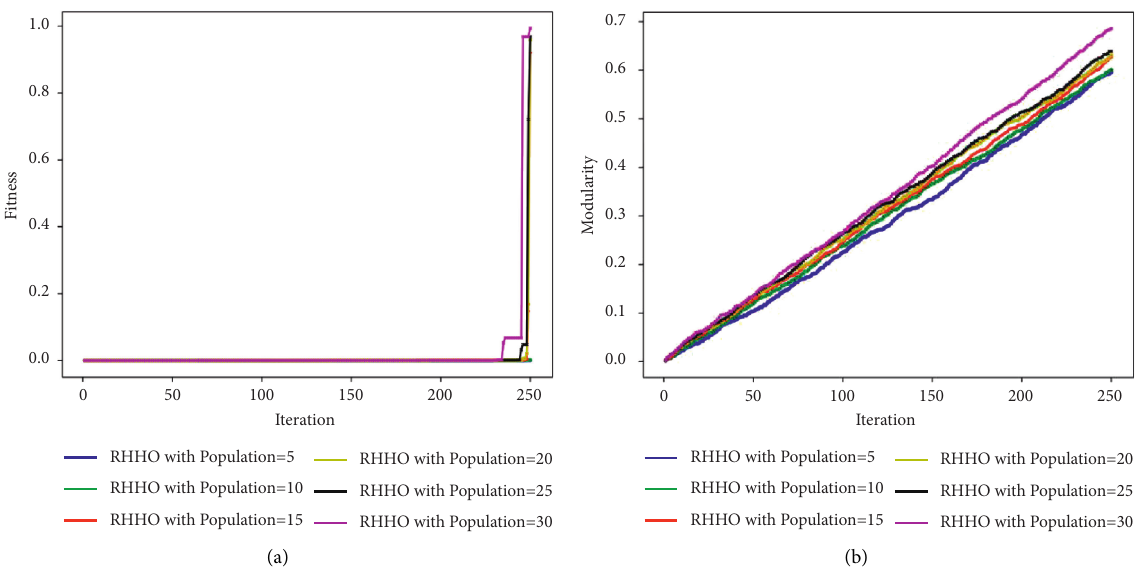
Figure 5: Performance analysis of proposed RHHO using the cit-HepTh considering (a) fitness and (b)